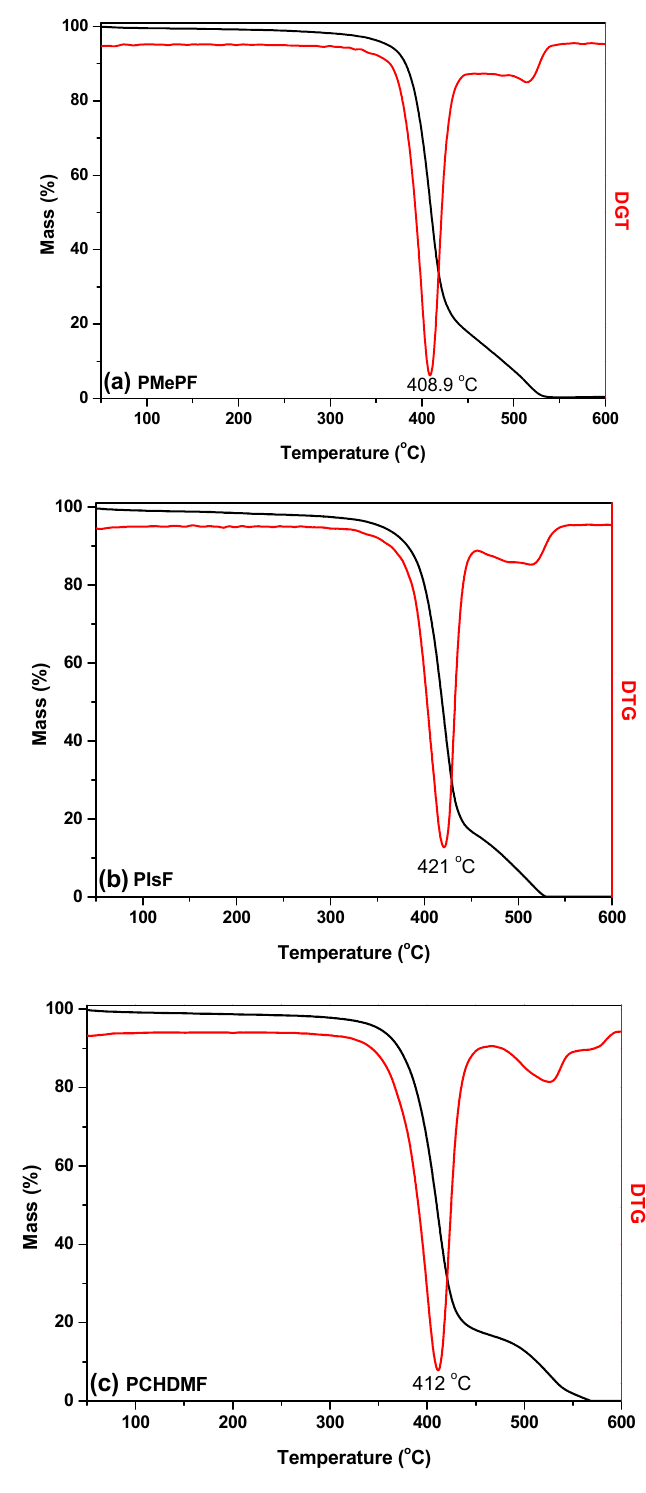
Figure 11. Remaining mass (TG) and differential (dTG) curves of ( a ) PMePF, ( b ) PIsF and ( c ) PCHDMF.